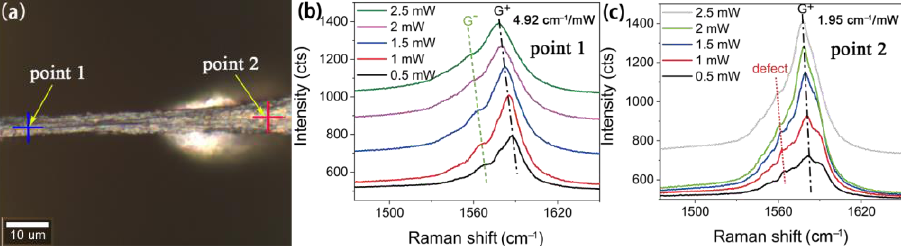
Figure 4. ( a ) Optical image of Sample 3, in which the position of blue cross marks point 1 and the position of red cross marks point 2; ( b ) Raman spectra of point 1 at different excitation light powers; ( c ) Raman spectra of point 2 at different excitation light